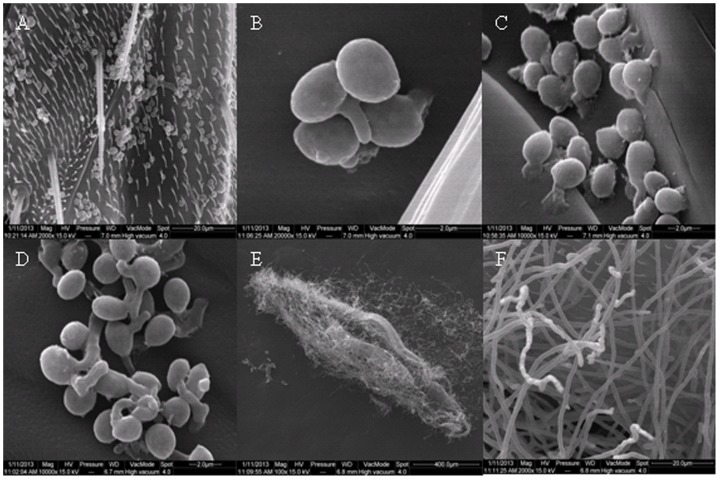
Germination and infection of B. bassiana strain SZ-26 conidia on the cuticle of F. occidentalis.(A) conidia adhering to the cuticle of F. occidentalis; (B) germ tube of conidia oriented toward cuticle; (C) germ tube penetratingthe cuticle; (D) fungal hyphae growing on the cuticle; (E) mycelium colonized the whole body; (F) conidia emerging from the dead adult.